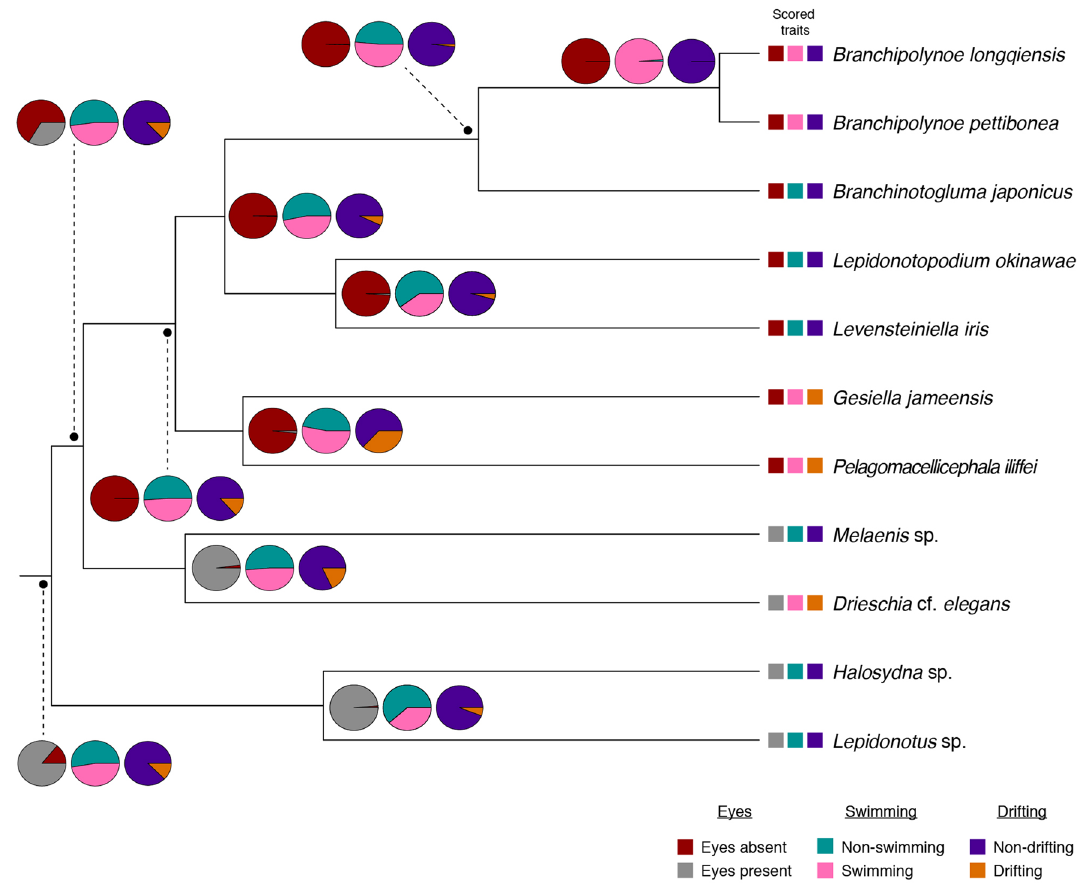
Figure 4. Reconstructed ancestral character estimations for Polynoidae. Coloured squares at branch tips correlate to scored traits for each taxon. Colour-coded pie charts reflect the overall probability of that character occurring in the ancestor of that particular node. Scored traits include “eyes” (absent/present), “swimming” (non-swimming/swimming) and “drifting”